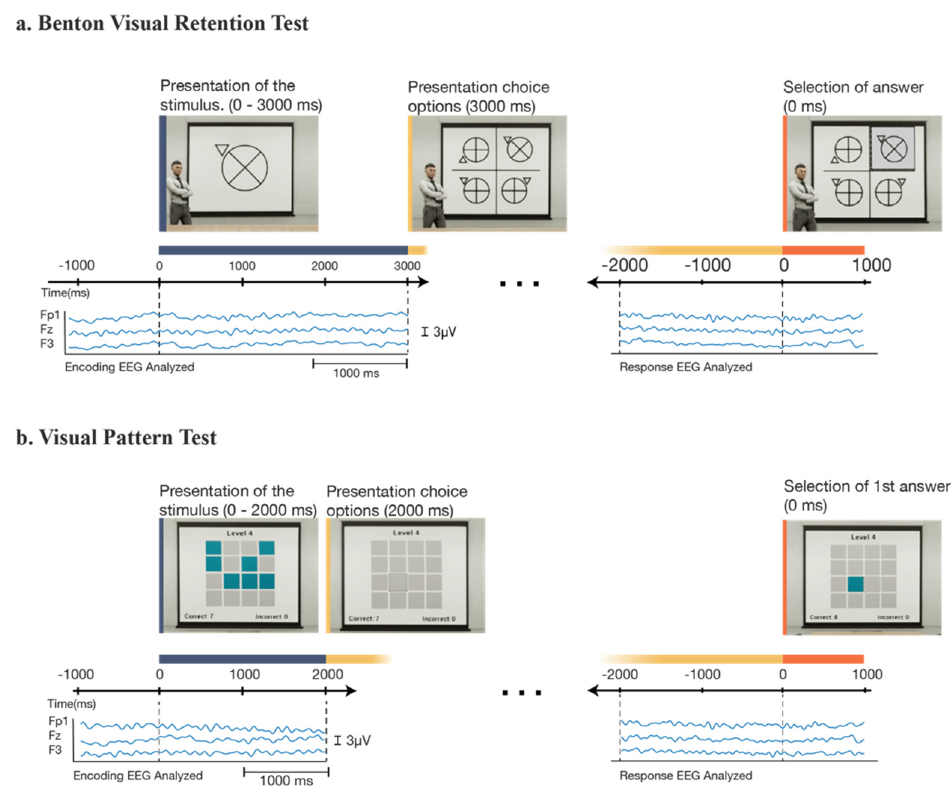
Figure 2. An overview of the experimental procedure. Behavioral responses and EEG data were collected for each participant in each of the four experimental conditions, starting with ( a ) the Benton test (under observed and non-observed conditions), and then continuing to ( b ) the visual patterns test (under observed and non-observed conditions). For each condition, participants completed 4 trials for a total of 16 trials. After each condition, participants indicated their stress and mental fatigue. In between tasks (BVRT and VPT), participants were given a 1 min rest. The same procedure was performed for the VPT, where a grid of randomly colored and uncolored squares was shown for 3 s. Immediately after this, the participant was shown a blank grid upon which they were asked to recreate the stimulus pattern.